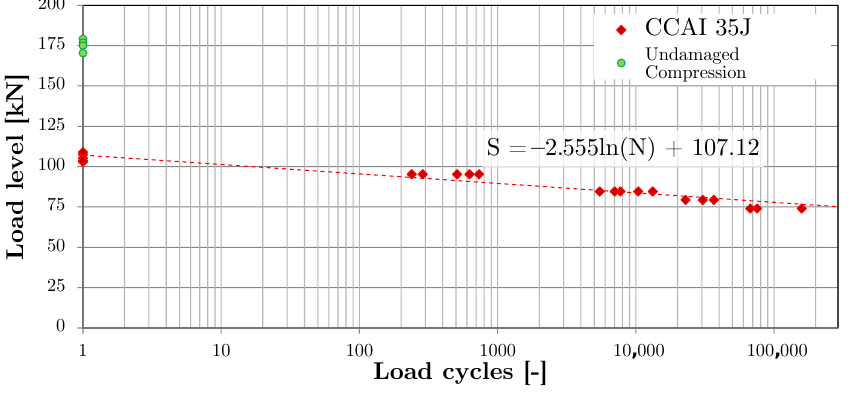
Figure 5. S-N-curve of the CCAI experiments with 35J impact